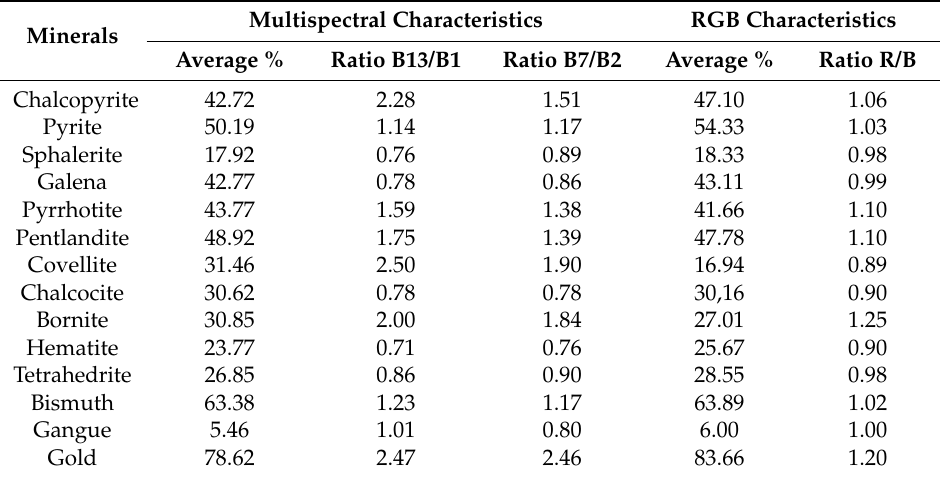
Table 5. Examples of specific multispectral characteristics (multispectral and color) that are unique to each mineral studied (averages in percent and